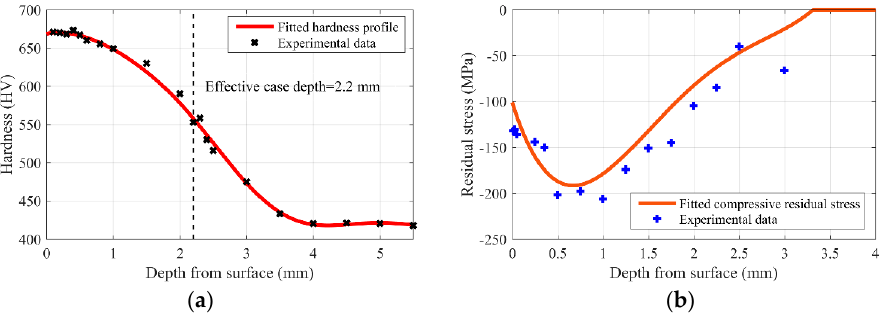
Figure 8. The fitted ( a ) hardness and ( b ) residual stress profiles based on the experimental method.